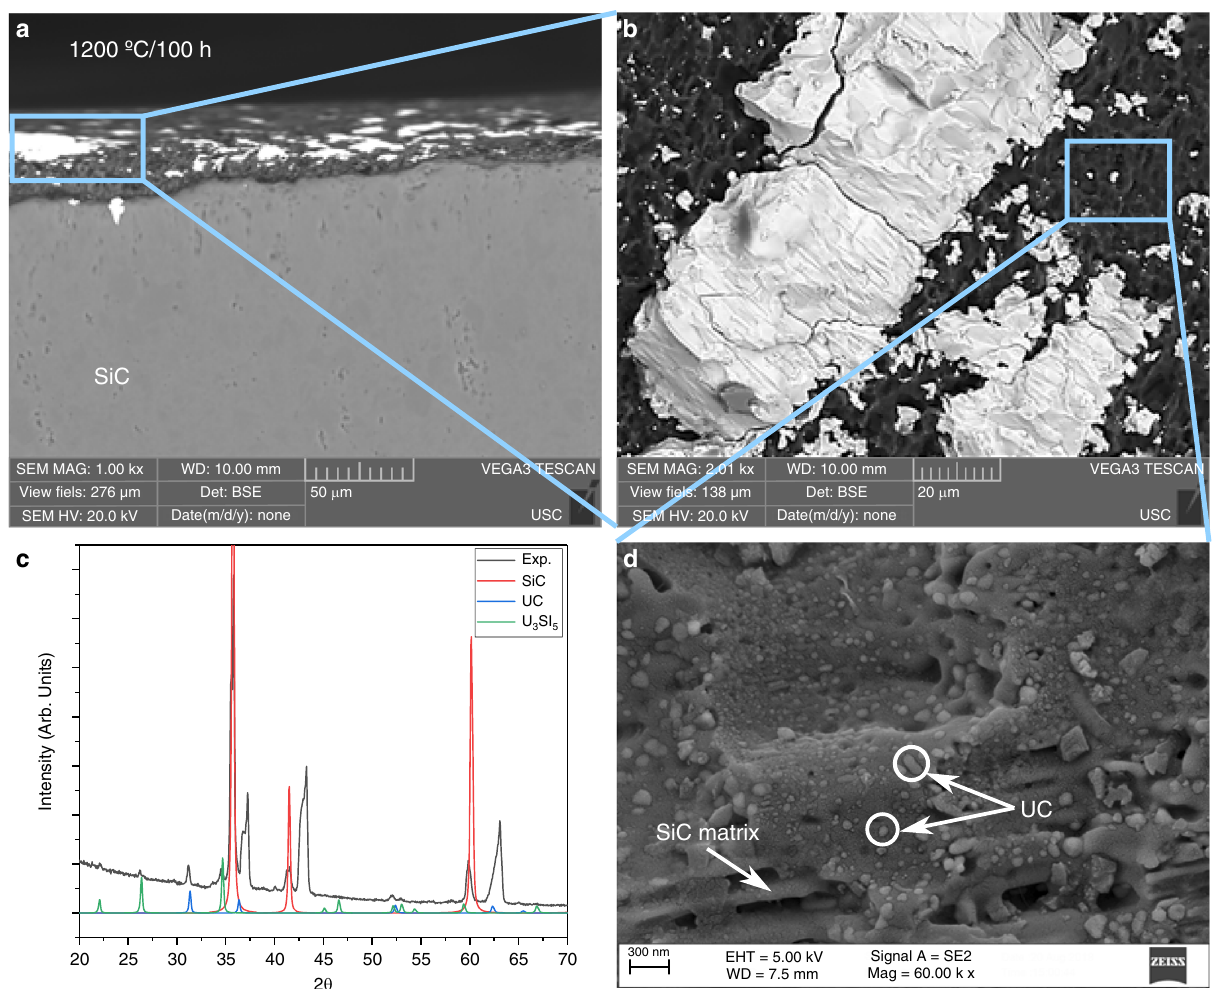
Fig. 2 Analysis of SiC. ( a – b , d ) SiC surface SEM images, and ( c ) low angle XRD, for a diffusion couple sample annealed at 1200 °C/100